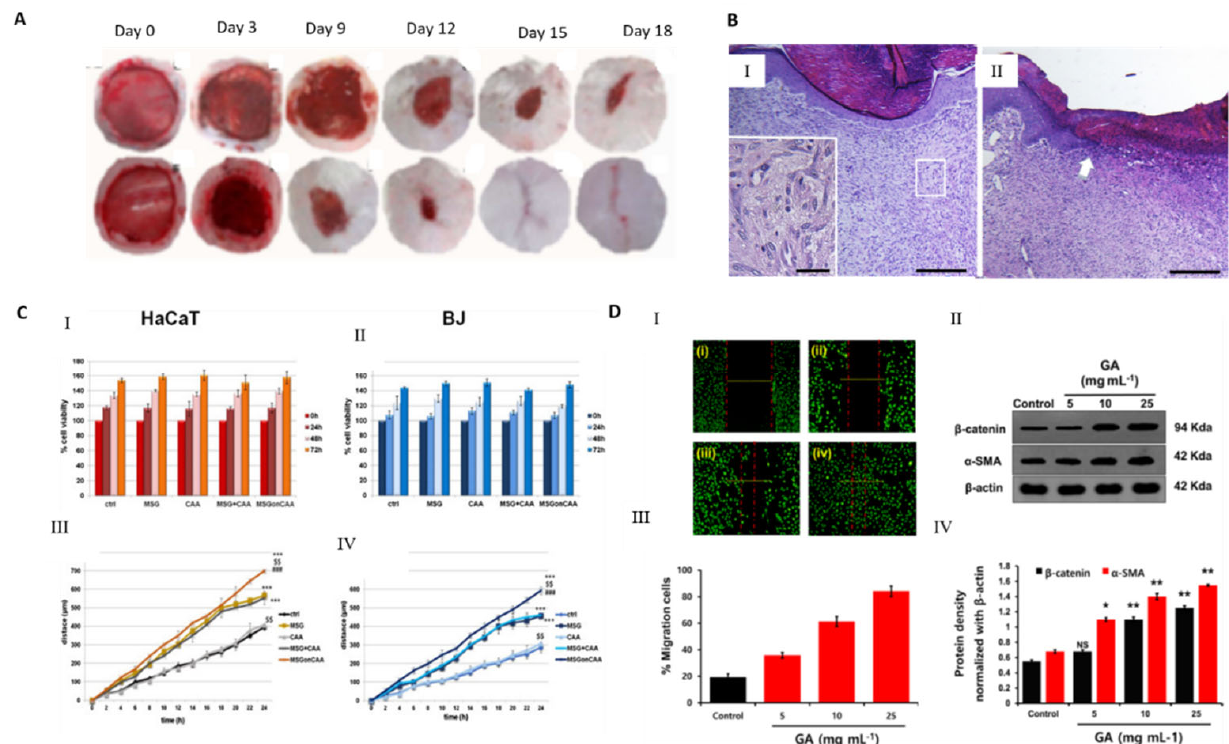
Figure 7. Use of bioaerogels in the treatment of wounds at the proliferative stage: ( A ) open excision wound healing test on native control collagen aerogels (first row) and on 2% wheat grass reinforced collagen aerogel (second row) in female Wistar rats. Adapted from ref [145]. Copyright 2017 American Chemical Society. ( B ) Micrographs of in vivo wound healing test showing ( I ) the appearance of the wound bed at day 14 after surgery. Treatment with CS/ChS aerogel has induced complete re-epidermization and proliferation of fibroblasts and production of collagen in dermis. The inset shows the dermis fibroblastic activity and neovascularization. An untreated control ( II ) shows at day 14 an epithelization tongue still in progress (white arrow) underneath the eschar (fibrin clot and necrotic detritus). In the dermis, scarring is observed with diffuse inflammatory infiltrated. Reprinted from ref [146], with permission from John Wiley and Sons. ( C ) MTT assays on ( I ) HaCaT and ( II ) BJ cells treated or not with pure mesoglycan (MSG), calcium alginate aerogel (CAA), MSG and CAA, and MSG impregnated on CAA, all of them at a final concentration of 0.3 mg/mL, at 24, 48 and 72 h; evaluation of migration rate of human ( III ) keratinocytes and ( IV ) fibroblasts in presence of pure MSG, CAA, MSG and CAA, and MSG impregnated on CAA. Reprinted from ref [102], with permission from Elsevier. ( D ) Cell proliferation on scratched lung epithelial cell surface promoted by GA: ( I ) cell growth migration in the control; ( II ) percentage index of migrated cells; ( III ) immunoblotting and ( IV ) intensity measurement of the expression levels of β -catenin and α -SMA on the scratched epithelial cell surface (5 × 10 4 cells/well) before and after treatment with different concentrations of GA (* p ≤ 0.05; ** p ≤ 0.01). Reprinted from ref [147]. Copyright 2019 American Chemical Society.